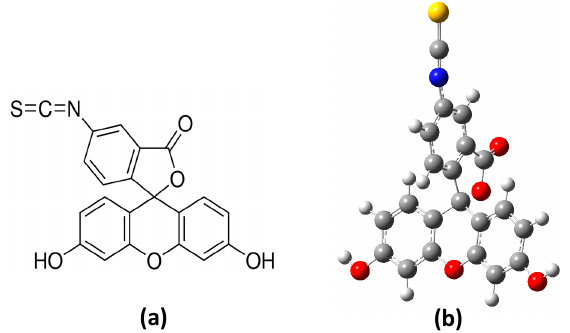
Figure 11. Schematic representation of ( a ) fluorescein and ( b ) geometry of the ground state (S 0 ) of the DFT calculation using the PCM solvation model. Table 1. Calculated states and electronic transitions, which determined the UV-vis optical absorption of fluorescein isothiocyanate in water (PCM